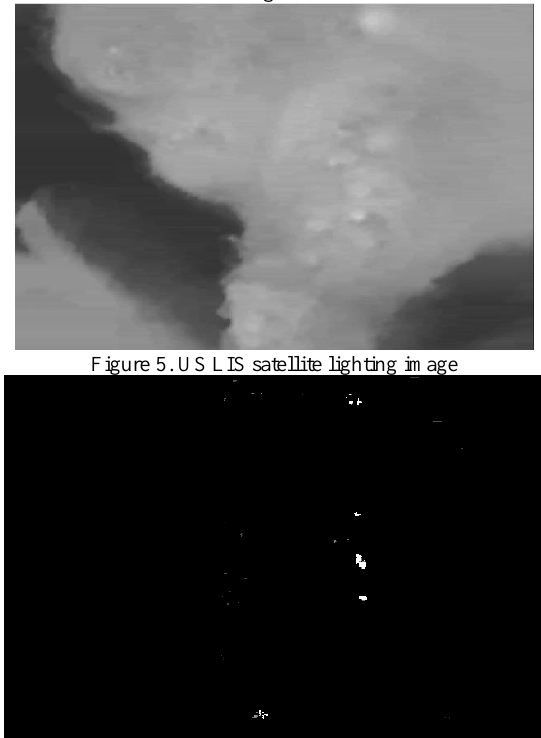
Figure 6. Detection result of the system